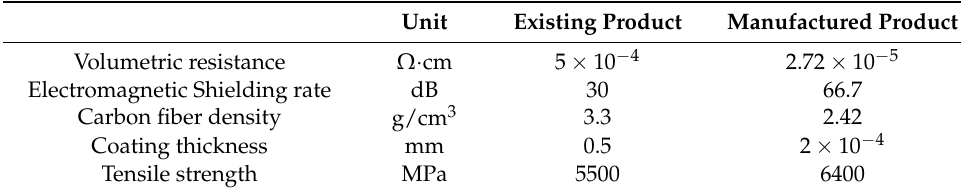
Figure 10. Metal-coated carbon fiber electromagnetic wave shielding film. Table 2. Performance of manufactured products. Table 2 compares five performance parameters of the existing nickel-plated carbon fiber and the manufactured nickel-plated carbon fiber.